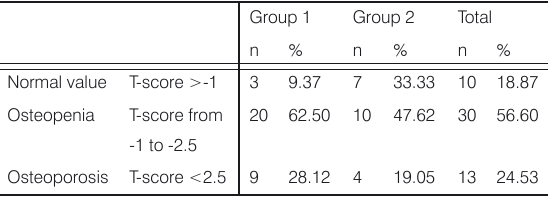
Bone mineral density (BMD) in patients with hypercholesterolemia, at study onset, was evaluated according to the T-score, as described in the Materials and Methods section. Abbreviations: n = number of patients in each group. Table 2. Baseline values of measured parameters in study groups.